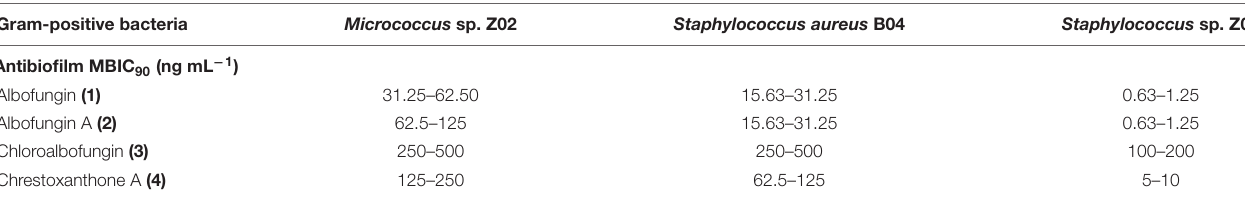
FIGURE 1 | (A) Chemical structures of albofungins ( 1 – 4 ) isolated from Streptomyces chrestomyceticus BCC 24770. (B) Genetic organization of albofungin biosynthesis gene cluster (She et al., 2021). TABLE 2 | Biofilm inhibition assay of albofungins ( 1 – 4 ) against gram-positive marine bacteria.